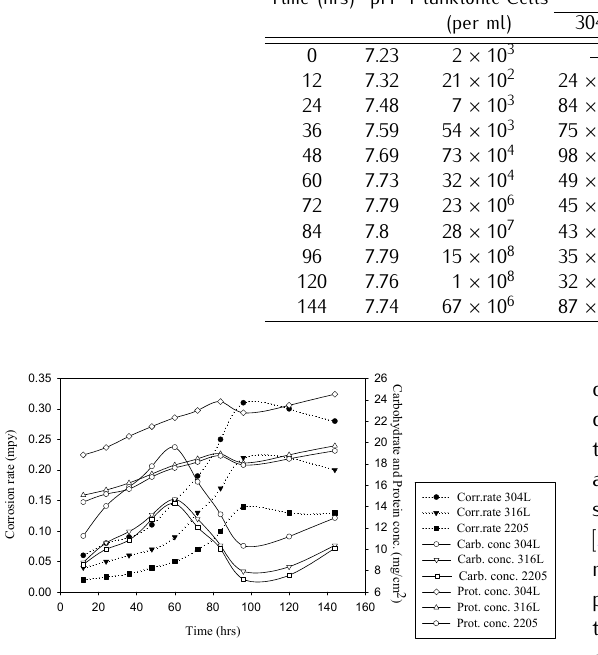
Fig. 2 Corelation between corrosion rate (mpy) and EPS component (Carbohydrate and Protein) of stainless steels with bacteria during immersion tests without media replenishing.